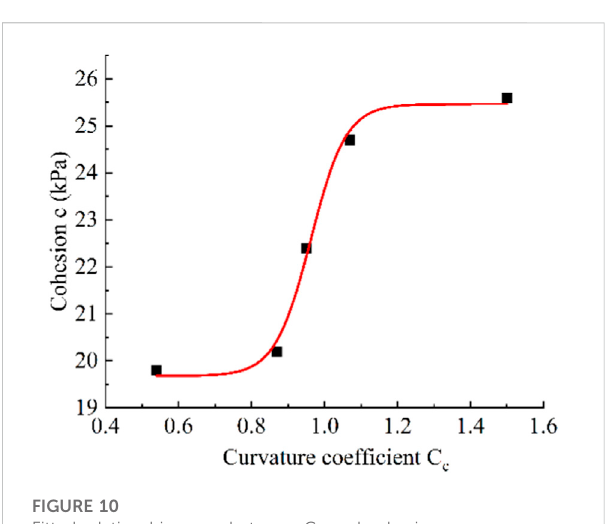
FIGURE 10 Fitted relationship curve between Cc and cohesion.